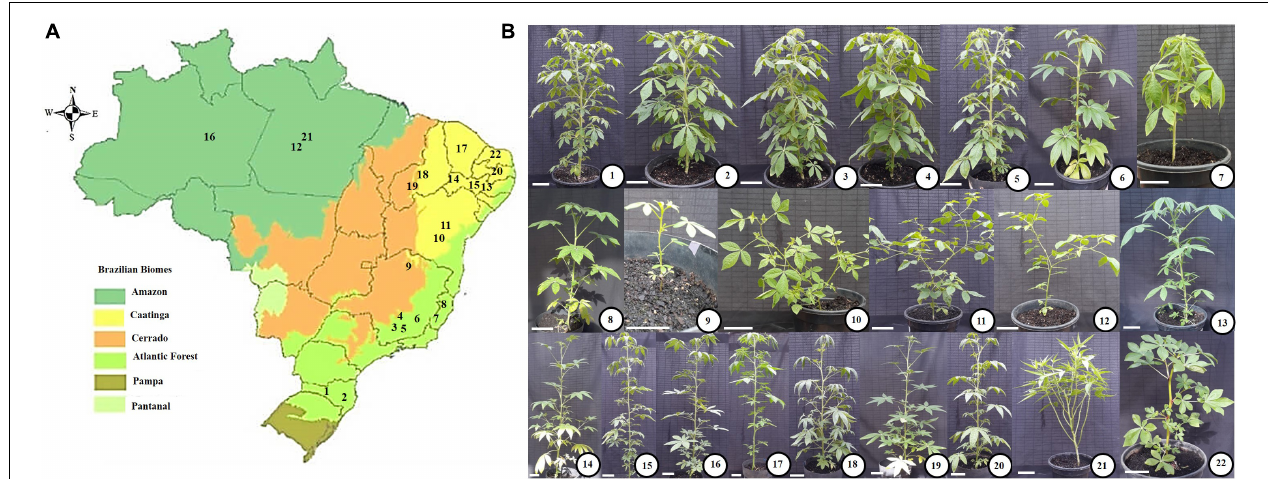
FIGURE 1 | Map of Brazil with its biomes (A) and pictures of the studied species (B) . (A) Map showing the Brazilian biomes, in which the sampling sites of the studied species are highlighted by numbers (following the description presented in B ). Accessions 1–8 were sampled from sites at Atlantic Forest; Accession 9 from Cerrado (Brazilian Savanna); Species 10, 11, 13–15, 17, 20, and 22 from Caatinga (Brazilian semi-arid region); Accessions 18 and 19 form transitional regions between Cerrado and Caatinga; Accessions 12, 16, and 21, from Amazon. (B) Pictures of the studied species, cultivated under greenhouse conditions (Please, see